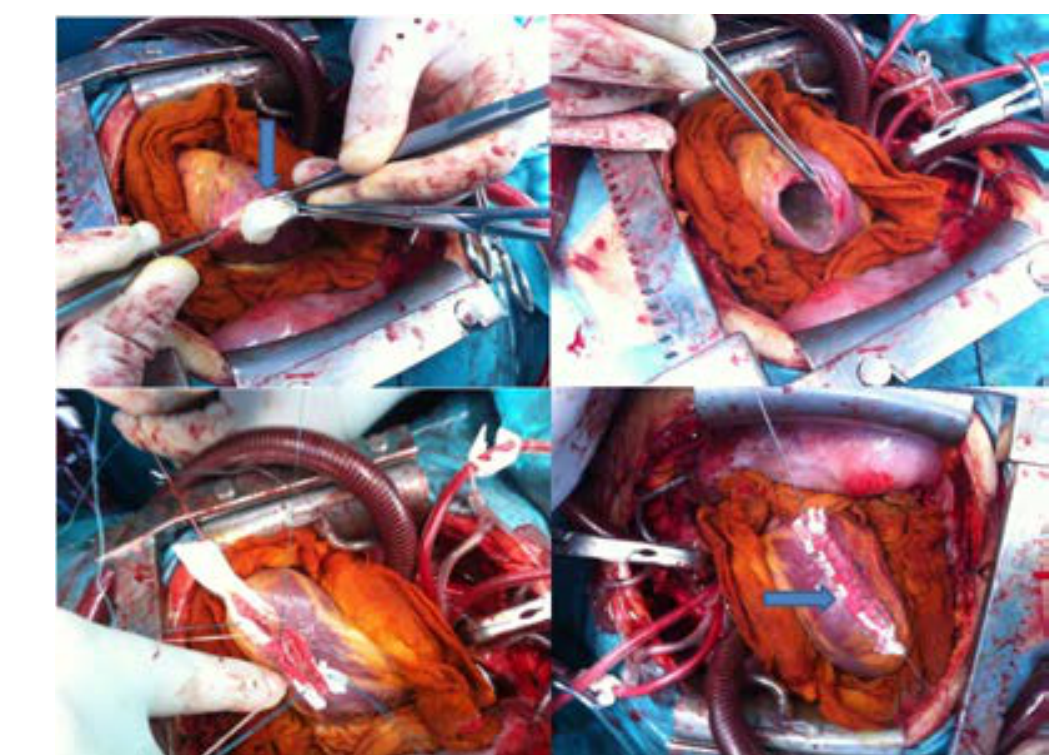
Fig. 2 – Cardiac hydatid cyst surgery–capitonnage similar to ventricular aneurysm repair.